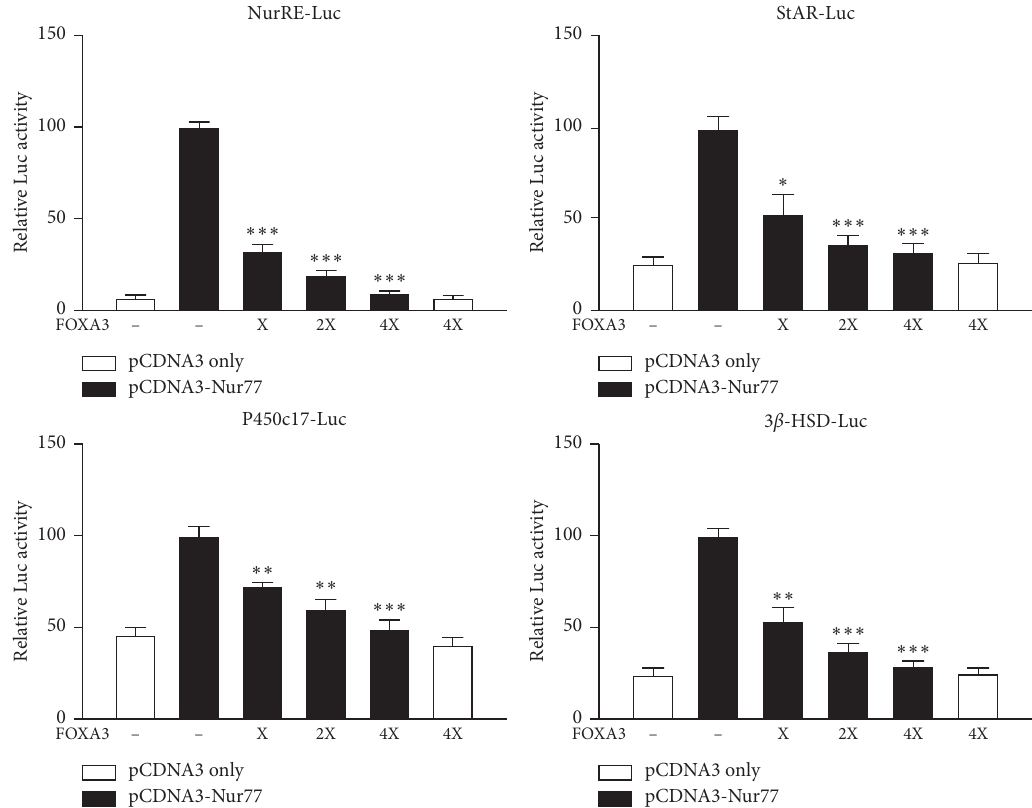
Figure 5: FOXA3 inhibits Nur77-mediated transactivation of steroidogenic gene promoters. FOXA3 represses Nur77-mediated trans- activation of steroidogenic gene promoters in a dose-dependent manner in MA-10 cells. Cells were transfected with different reporter constructs, SV-40 β -gal, and indicated concentration of FOXA3 (X represents 100ng of the expression construct) for 48h Luciferase activity was normalized to β -galactosidase activity. The cAMP induced controls were considered 100% for comparison, and the t -test was performed to analyze statistical significance. ∗ P < 0 . 01; ∗∗ P < 0 . 001; ∗∗∗ P < 0 .